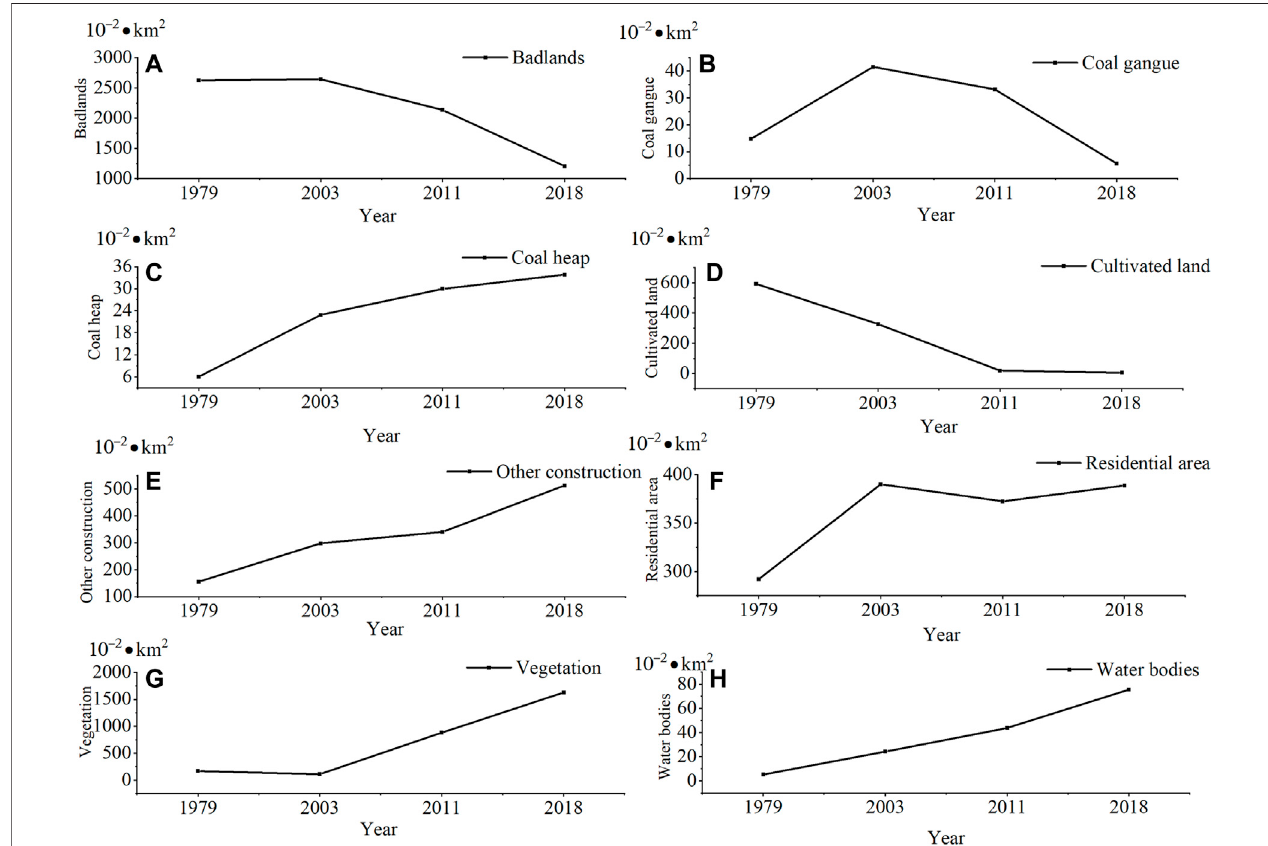
FIGURE12| Statisticalchartoftheareachange ofvarious land-useclasses. (A) Changesinthebadlands, (B) changesinthecoal gangue, (C) changesinthecoal heaps, (D) changesinthecultivatedland, (E) changesintheotherconstruction, (F) changesintheresidentialarea, (G) changesinthevegetation,and (H) changesinthe water